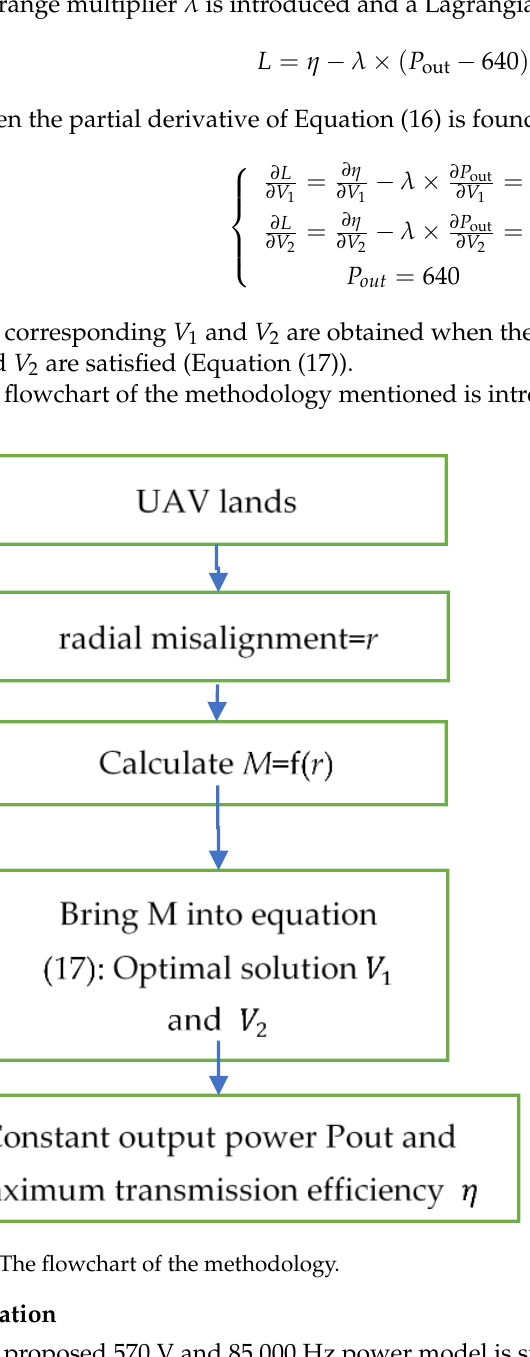
Table 1. Parameters of the system. Parameter